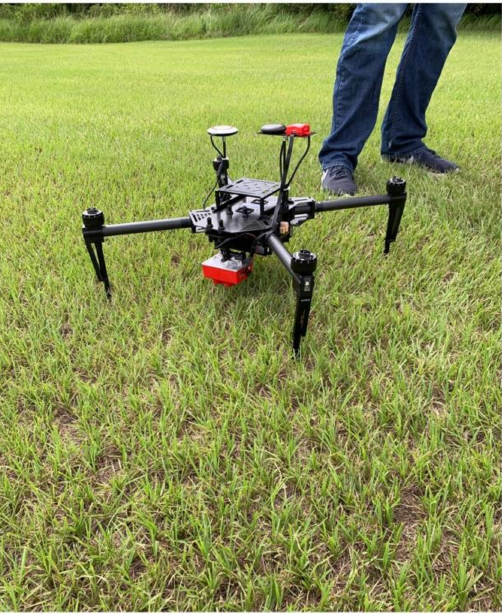
Figure 2. The DJI Matrice 100 with the Micasense Red Edge-M multi-spectral camera. Ground control points (GCPs) were collected using an Emlid Reach RS2 RTK